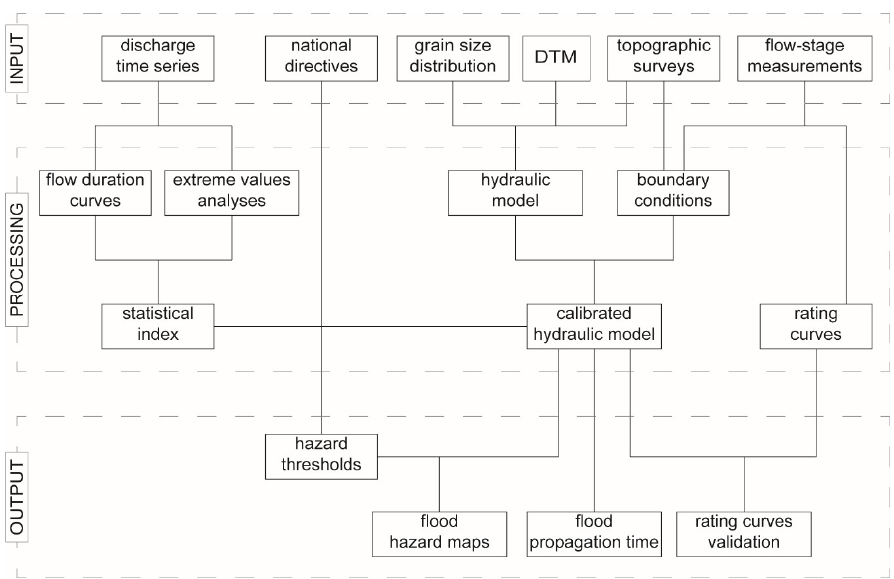
Figure 4. Workflow: Data collection (input); elaboration of collected data (processing) and outcomes of the work (output).